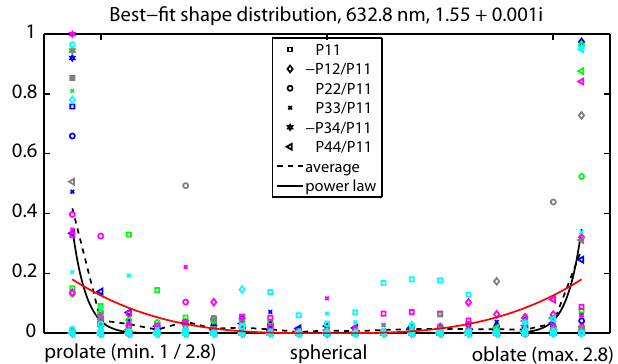
Fig. 4. Scatter plot of weights obtained for different spheroidal shapes when fitting different scattering-matrix elements of all sam- ples considered. The colors refer to different samples: feldspar (blue), red clay (gray), green clay (green), loess (pink), and Saharan dust (black). Only the wavelength λ = 632 . 8nm has been consid- ered and m has been fixed at 1 . 55 + 0 . 001 i . Solid lines represent ξ n shape distributions with different values for n : the black line shows n = 18 that is the best value for this particular scatter plot, and the red line, corresponding to n = 3, is shown for